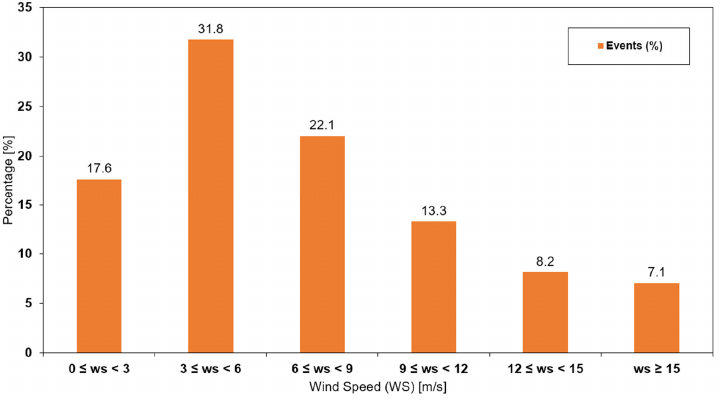
Figure 7. Distribution of wind speed classes.